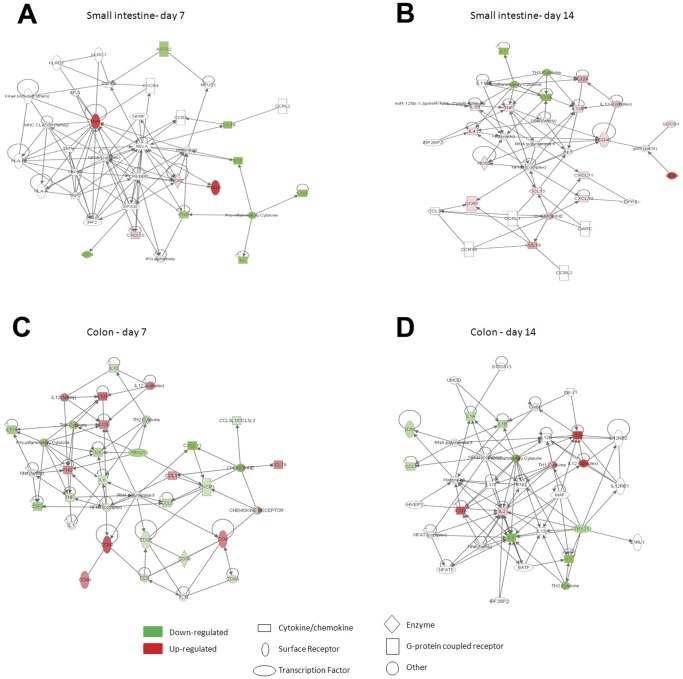
Ingenuity Pathway gene networks.The most highly significant gene networks identified in the Ingenuity Pathway analysis of the gene expression data in response to PM10 are shown for small intestine at days 7(A) and 14(B) and colon at days 7(C) and (D). The networks are displayed graphically as nodes (genes/gene products) and edges (the biological relationships between the nodes). The intensity of the node color indicates the degree of up (red) or down (green) regulation in gene expression. Nodes are displayed using shapes that represent the functional class of the gene product. Edges are displayed as a direct interaction (solid line).